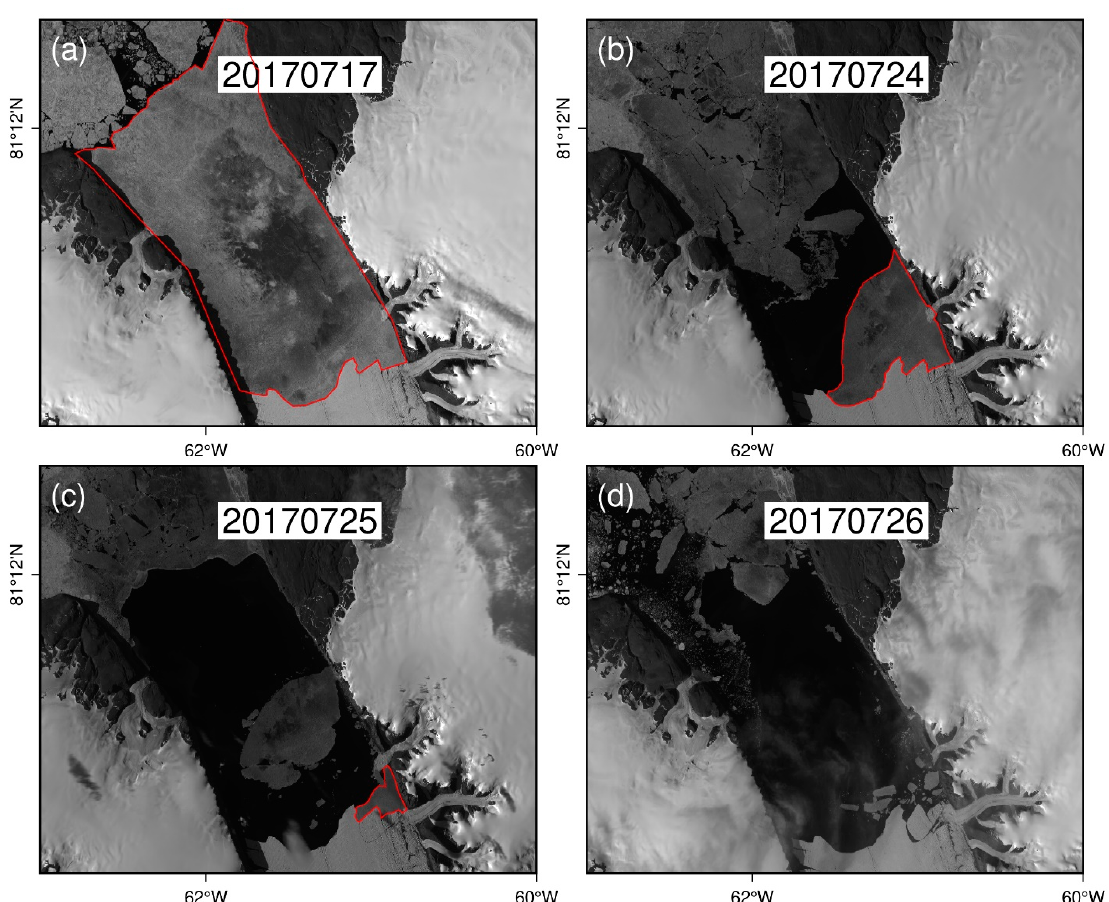
Figure 8. The outline of landfast sea-ice images of Landsat 8 in the Petermann glacier fjord in July of 2017. The red polygon region denotes the extent of landfast sea ice in ( a – c ). ( d ) The landfast sea ice has completely disappeared.